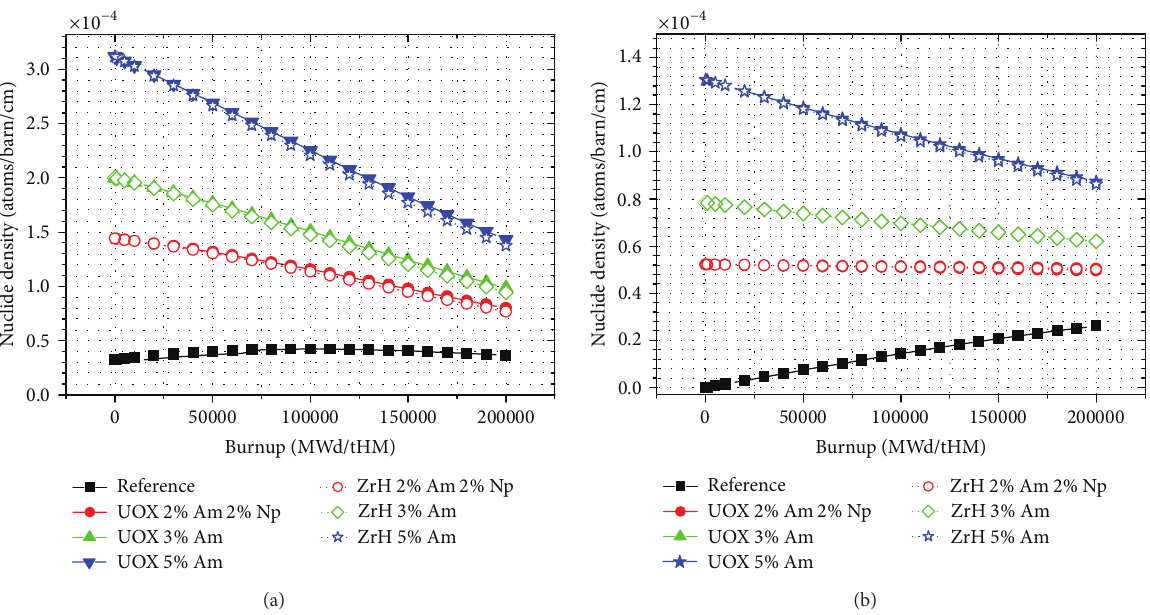
Figure 7: Change in the Americium-241 (a) and the Americium-243 (b) content over burnup for the case with and without moderation.